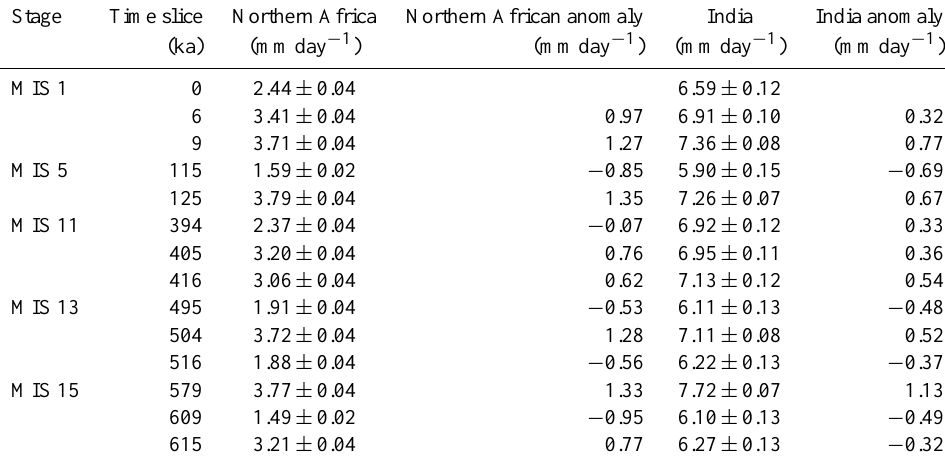
Table 2. Summer (JJAS) precipitation over northern Africa (20 ◦ W–30 ◦ E and 10–25 ◦ N) and over India (70–100 ◦ E and 10–30 ◦ N) along with anomalies relative to PI. Absolute precipitation values are given with standard error (2 σ ) based on 100 simulation years of each experiment. Stage Time slice Northern Africa Northern African